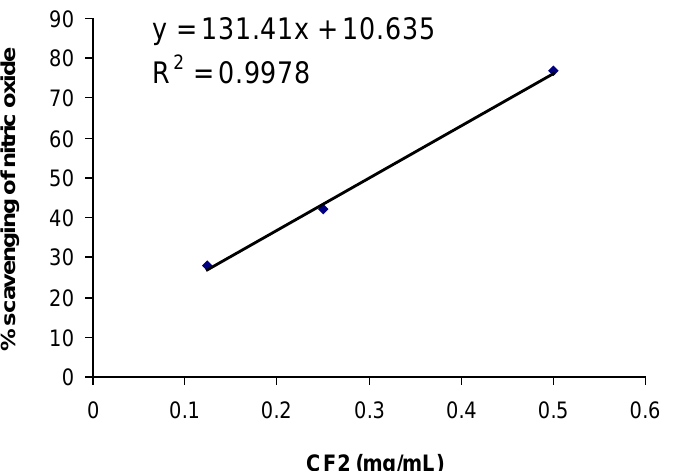
Figure 4. Effect of Orthosiphon stamineus CF2 on nitric oxide (NO) scavenging.